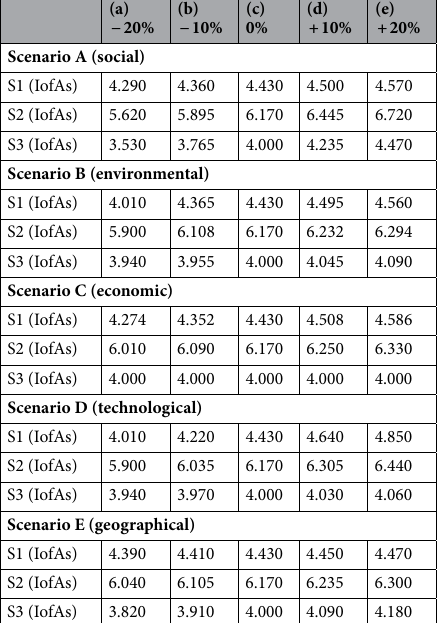
Table 7. The values of IofAs for the different scenarios.